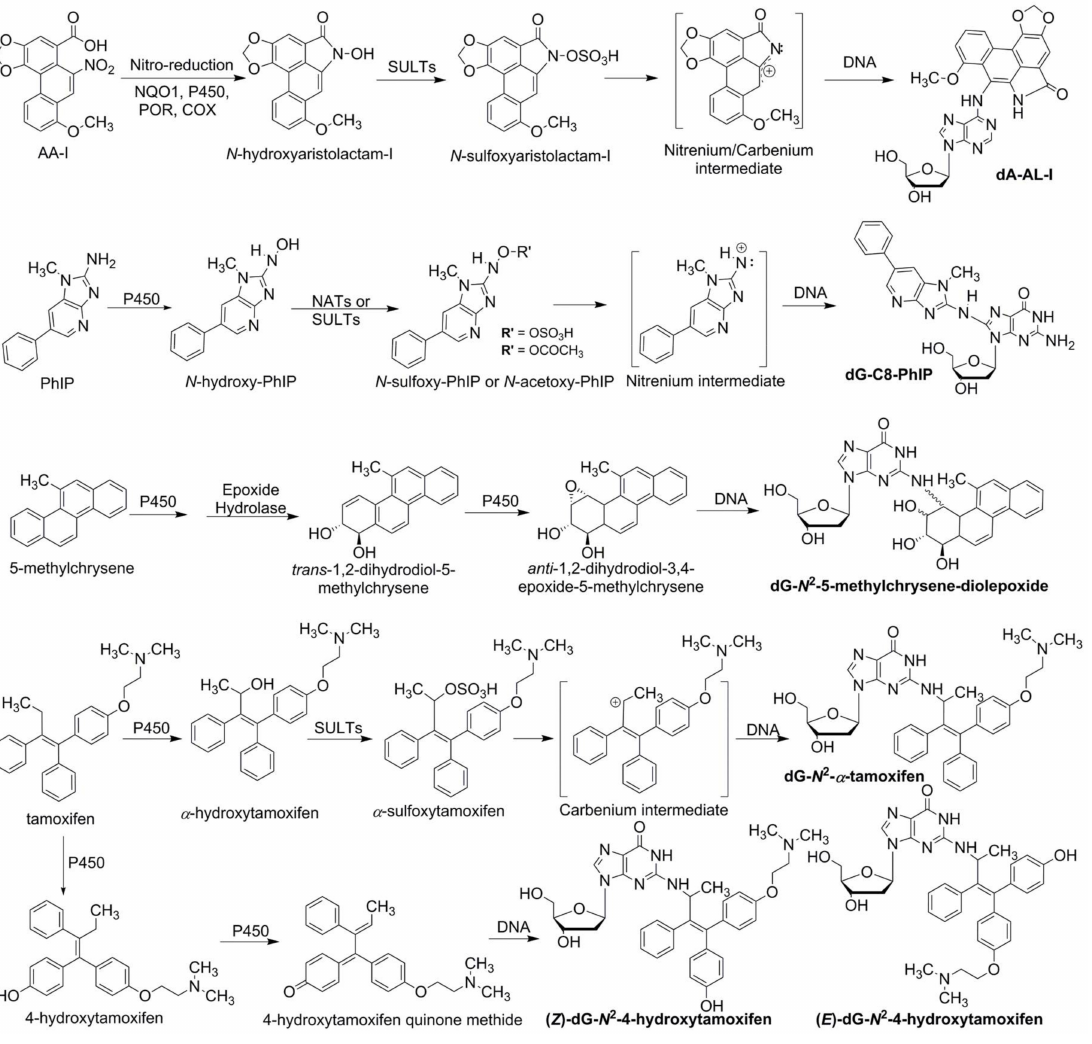
Figure 1. The metabolic activation of aristolochic acid I (AA-I), 2-amino-1-methyl-6-phenylimidazo[4,5- b ]pyridine (PhIP), 5-methylchrysene, and tamoxifen are shown as prototypes of procarcinogens. Bioactivation is carried out with phase I and/or phase II enzymes, which lead to the formation of DNA adducts. AA-I undergoes nitro-reduction through NAD(P)H:quinone oxidoreductase (NQO1), cytochrome P450s 1A1 and 1A2, NADPH:P450 reductase (POR) or prostaglandin H synthase